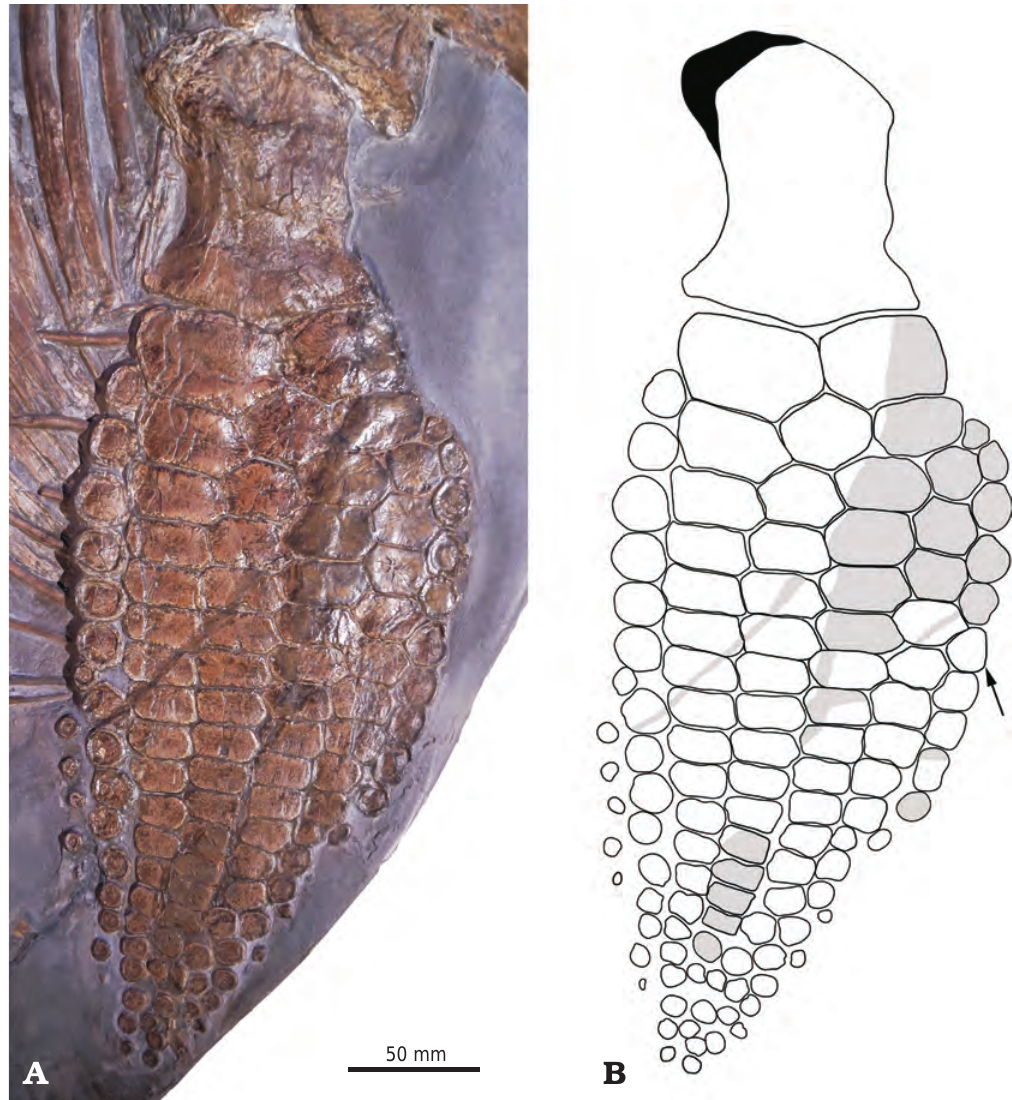
Fig. 4. Right forefin of Ichthyosaurus somersetensis Lomax and Massare, 2017 (NLMH 106234) from the Lower Jurassic (lower Hettangian) of Doniford Bay, Watchet, Somerset, UK; in dorsal view (anterior to the right). Grey indicates plaster filler (elements are not genuine); black indicates crushed and displaced portion of humerus. Arrow points to bifurcation. Photograph ( A ), explanatory drawing ( B